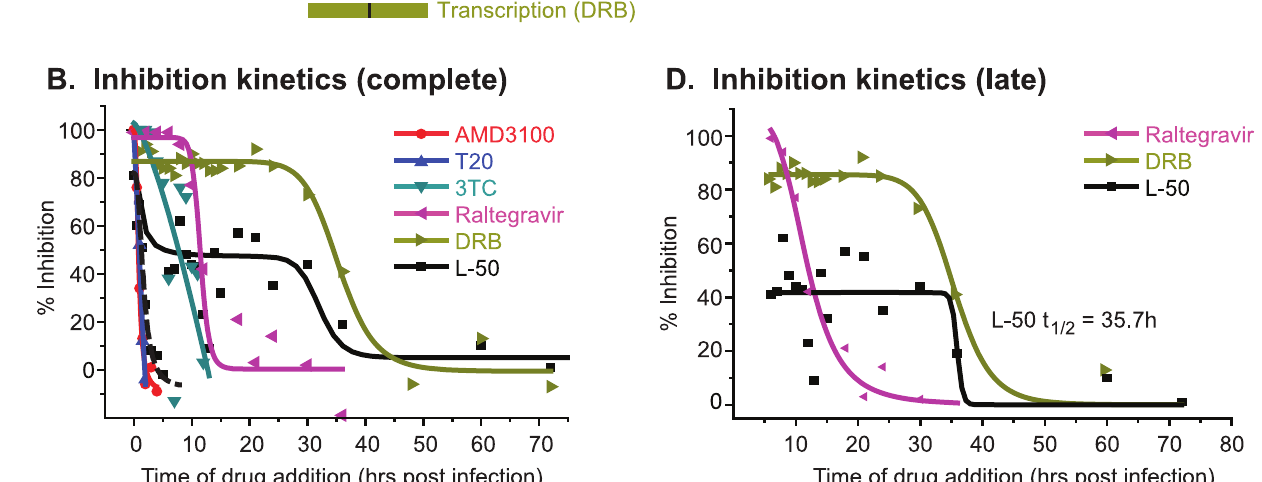
Figure 5. Time-of-drug-addition experiment during synchronized HIV-1 infections. Panel ( A ) provides a schematic representation of the experimental protocol, including the spinoculation step for synchronized virus infection and timing of drug additions over the 72 h time course. The relative time frame associated with each retroviral step is defined based on the time frame of sensitivity to the drug that blocks that particular replication step. Panel ( B ) plots the level of inhibition mediated by a specific drug added at a specific time post infection. Virus production, regardless of the timing of drug addition, was measured by luciferase activity at 72 h post infection. Curves are fitted to % inhibition mediated by the timed addition of each drug. Inhibition by a drug is absent after the completion of the specific step known to be a target of that drug. For example, AMD3100 bind CXCR4 and prevents HIV-1 entry; thus, inhibition of HIV-1 by AMD3100 is not observed if the drug is added . 2 h post infection, i.e. after the HIV-1 entry step is complete. A biphasic curve was fitted to inhibition mediated by timed addition of L50. The first 12 hours of the timed drug addition was magnified to examine the inhibition of HIV-1 entry and reverse transcription (panel C ; early events). These early steps of HIV-1 replication were removed from the plots in panel D (late events) to focus on the timed inhibition by integration and transcription inhibitors. The times of drug addition that maintains 50% inhibition (t 1/2 ) are shown for each drug in the insets. All time-of-drug-inhibition experiments were performed in triplicate which resulted in a 10–15% variance in the inhibition levels. Error bars are not shown to prevent figure